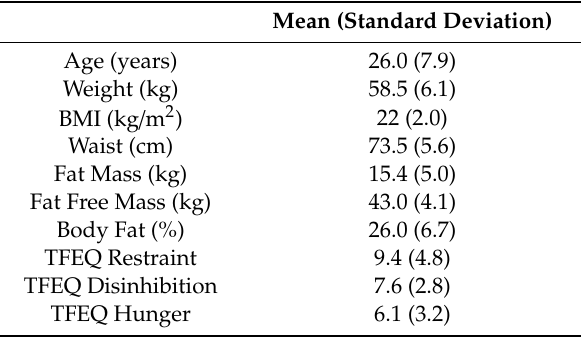
Table 2. Mean (SD) for age, anthropometrics, body composition and trait